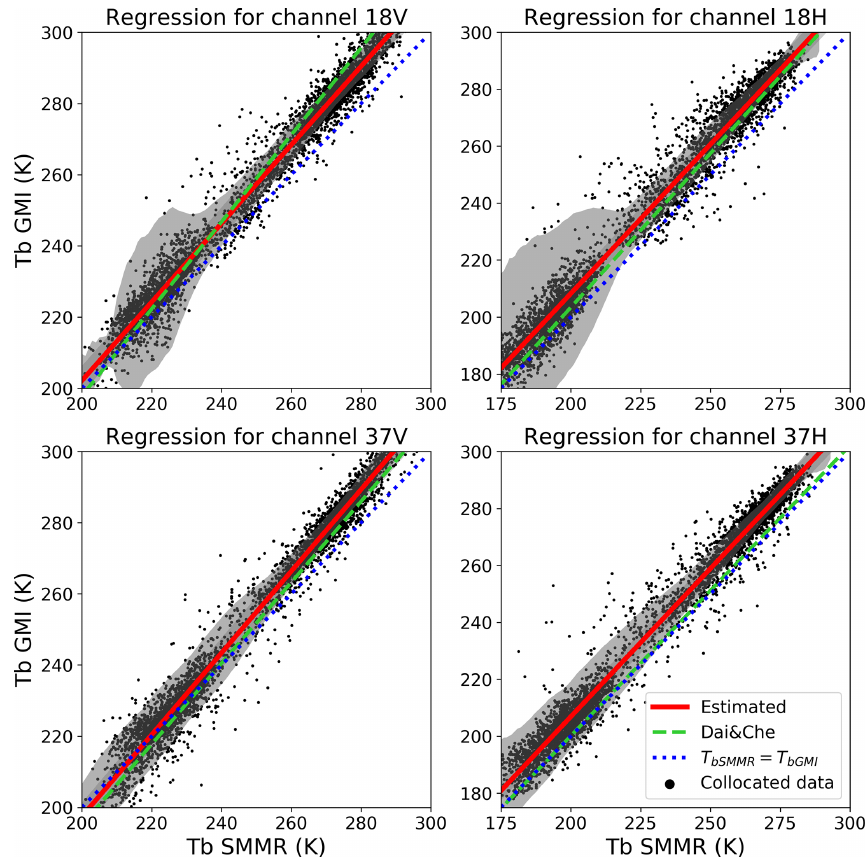
Figure 3. Linear regression on SMMR values against GMI after filtering points. In addition the correction derived by Dai and Che (2009) (and corrected for the SSM/I F08-to-GMI calibration) is